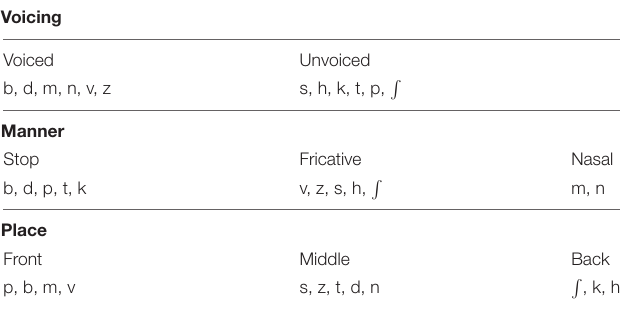
TABLE 1 | Phonetic feature